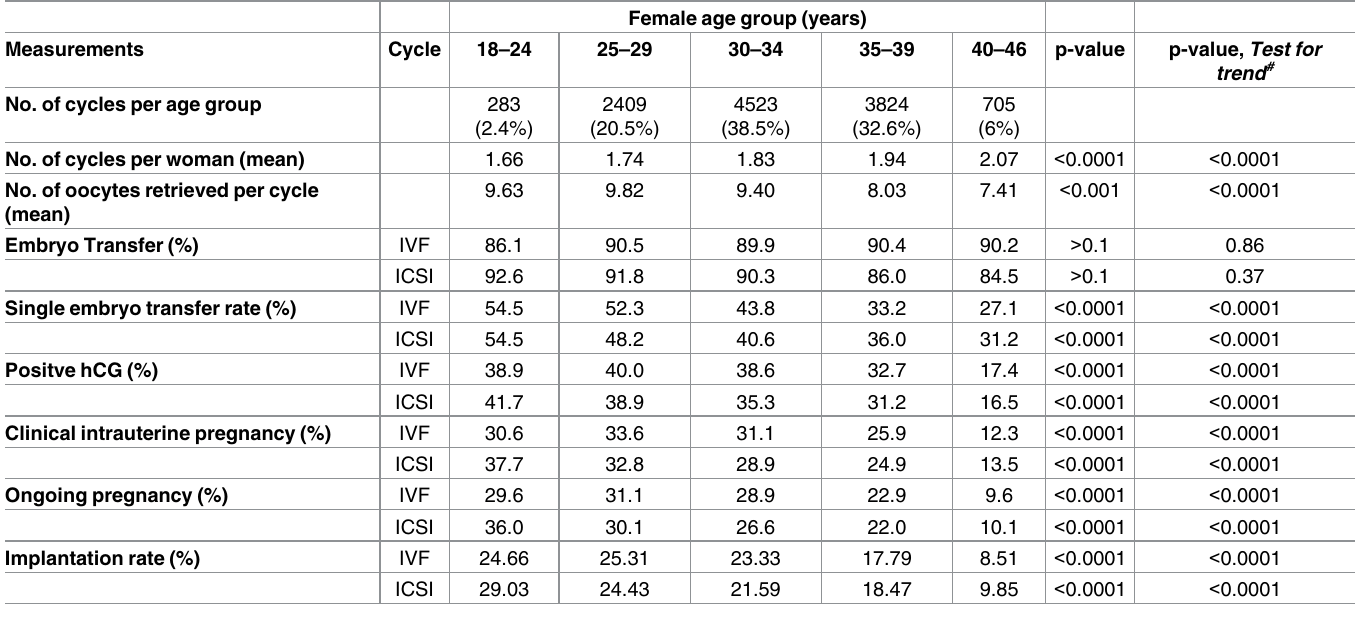
Table 2. The effect of women’s age on treatment practice and clinical outcome measuresafter IVF and